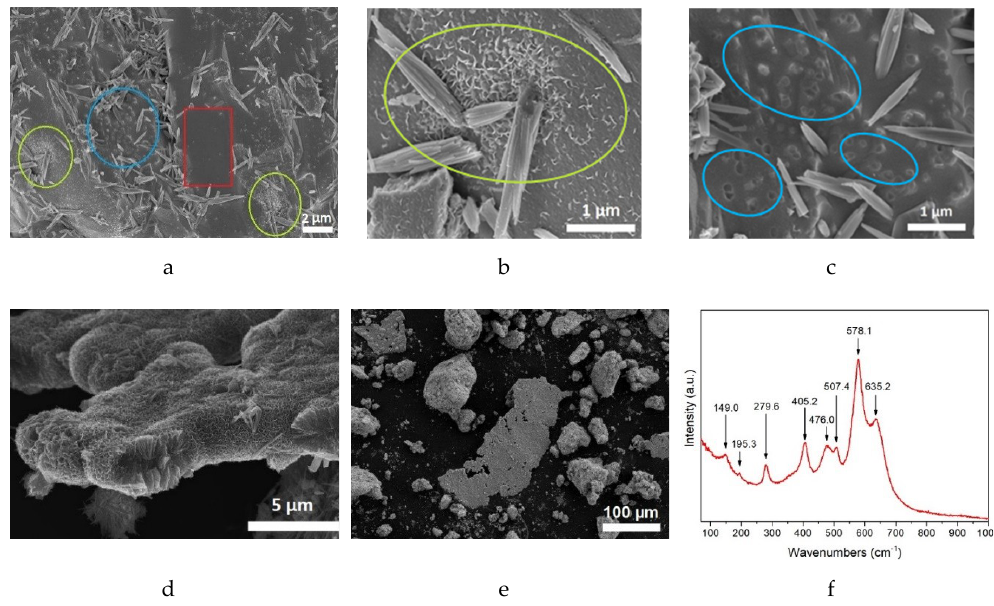
Figure 5. SEM micrographs of ( a – c ) the surface of 24 h-corroded grains: ( a ) x = 0.12; ( b , c ) x = 0.26. ( d , e ) view of a corrosion product aside from a grain for ( d ) x = 0.26 corroded 4 weeks and ( e ) 18 weeks. Three different morphologies are visible: Blue circles: porosities; Green circles: preferred nucleation with petal-shaped seeds; Red area: no germs or needles. ( f ) Raman spectra of the Mn-rich phase (after 18 weeks) identified as K-birnessite (frequencies reported by arrows are attributed to birnessite by comparison with [35]).